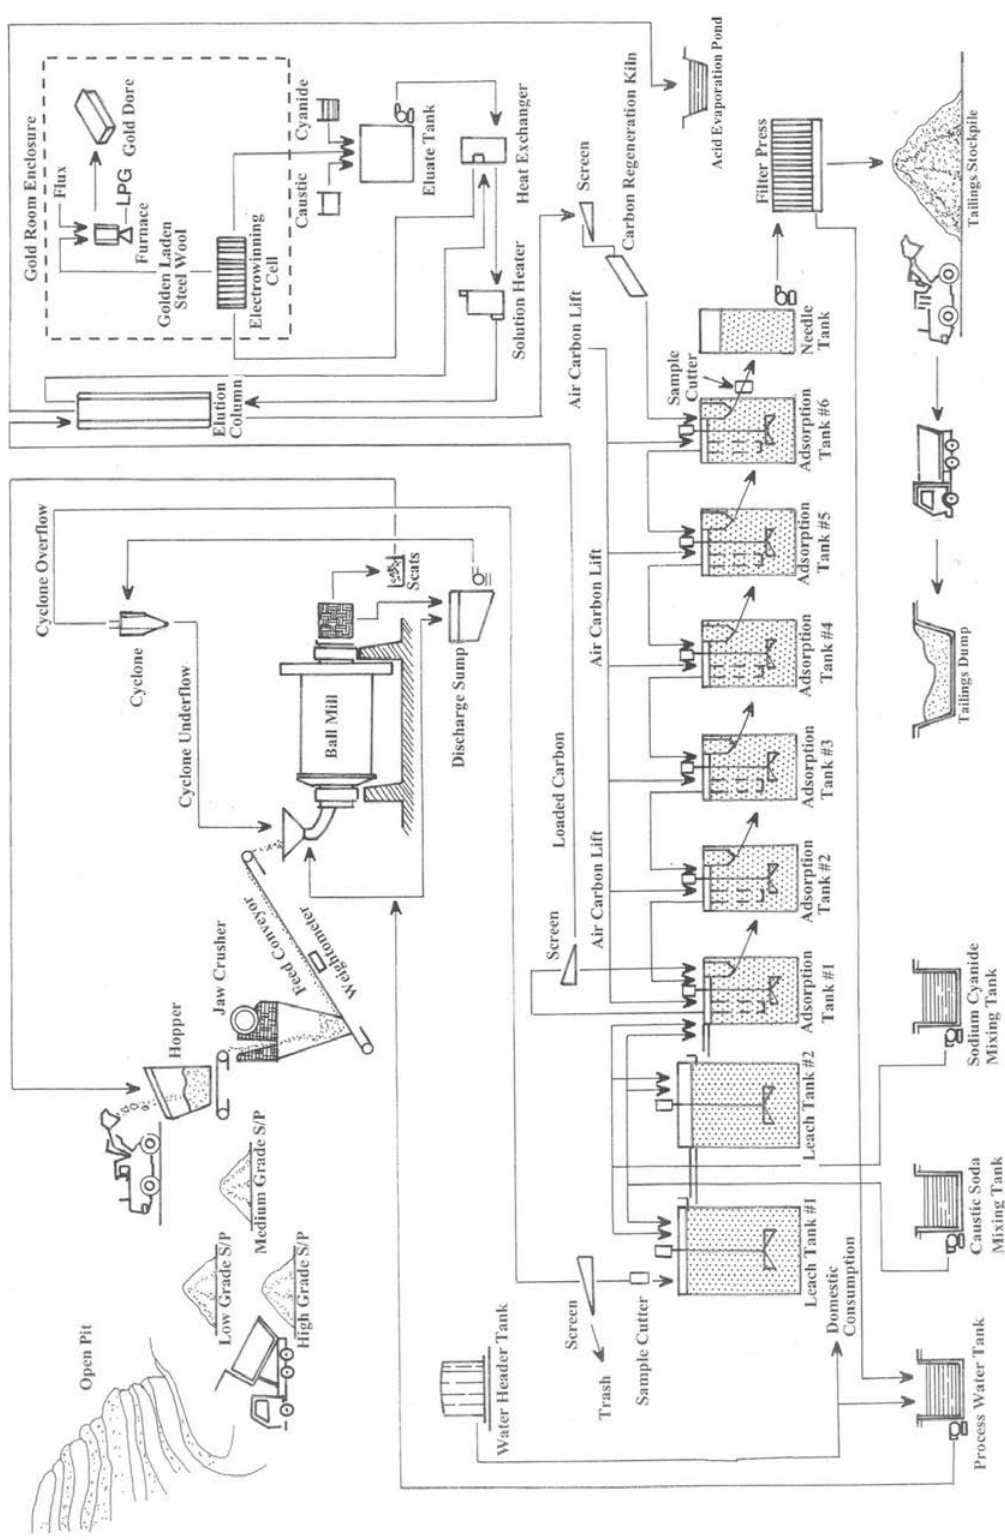
Figure 1. Flow chart of gold mining